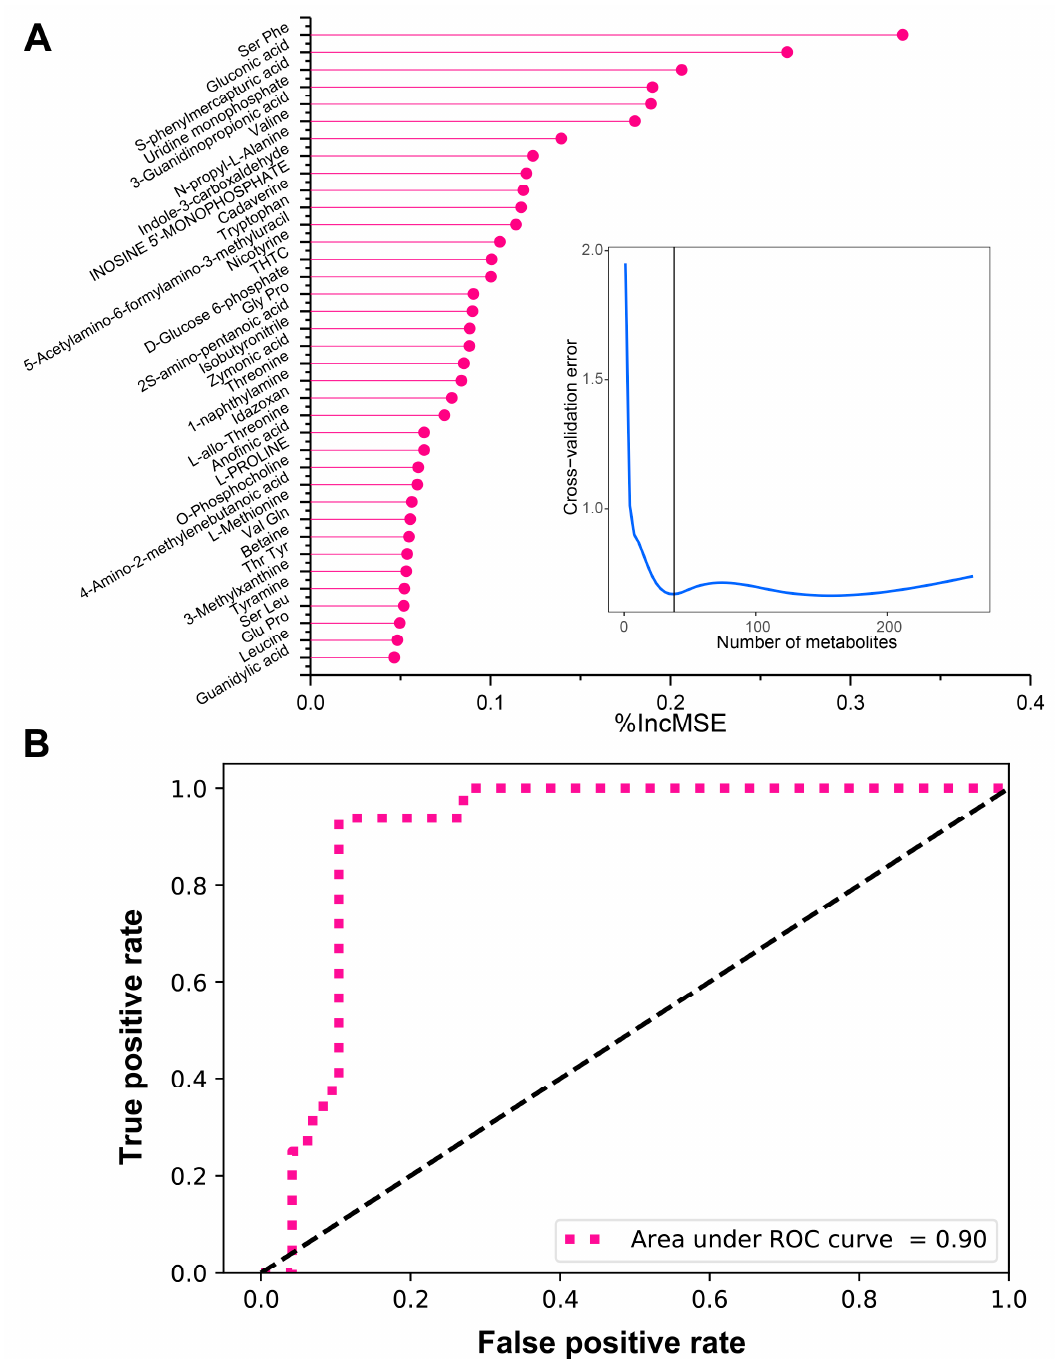
Figure 3. Potential biomarker screening by the random forest regression model. ( A ) Dot plot represents the top 37 metabolic biomarkers identified by using random forest regression. The metabolic biomarkers are ranked in descending order of the percent increase in mean square error (%IncMSE). The insert line plot represents 10-fold cross-validation with ten repeats that evaluates the importance of metabolites. The minimum cross-validation error was obtained when using 37 important metabolites; ( B ) receiver operating characteristic (ROC) curve of the potential metabolic biomarkers identified by the random forest regression model. The random forest model achieved a higher area under the ROC curve (AUC) of 0.90, indicating the excellent performance of the constructed model using the random forest method.